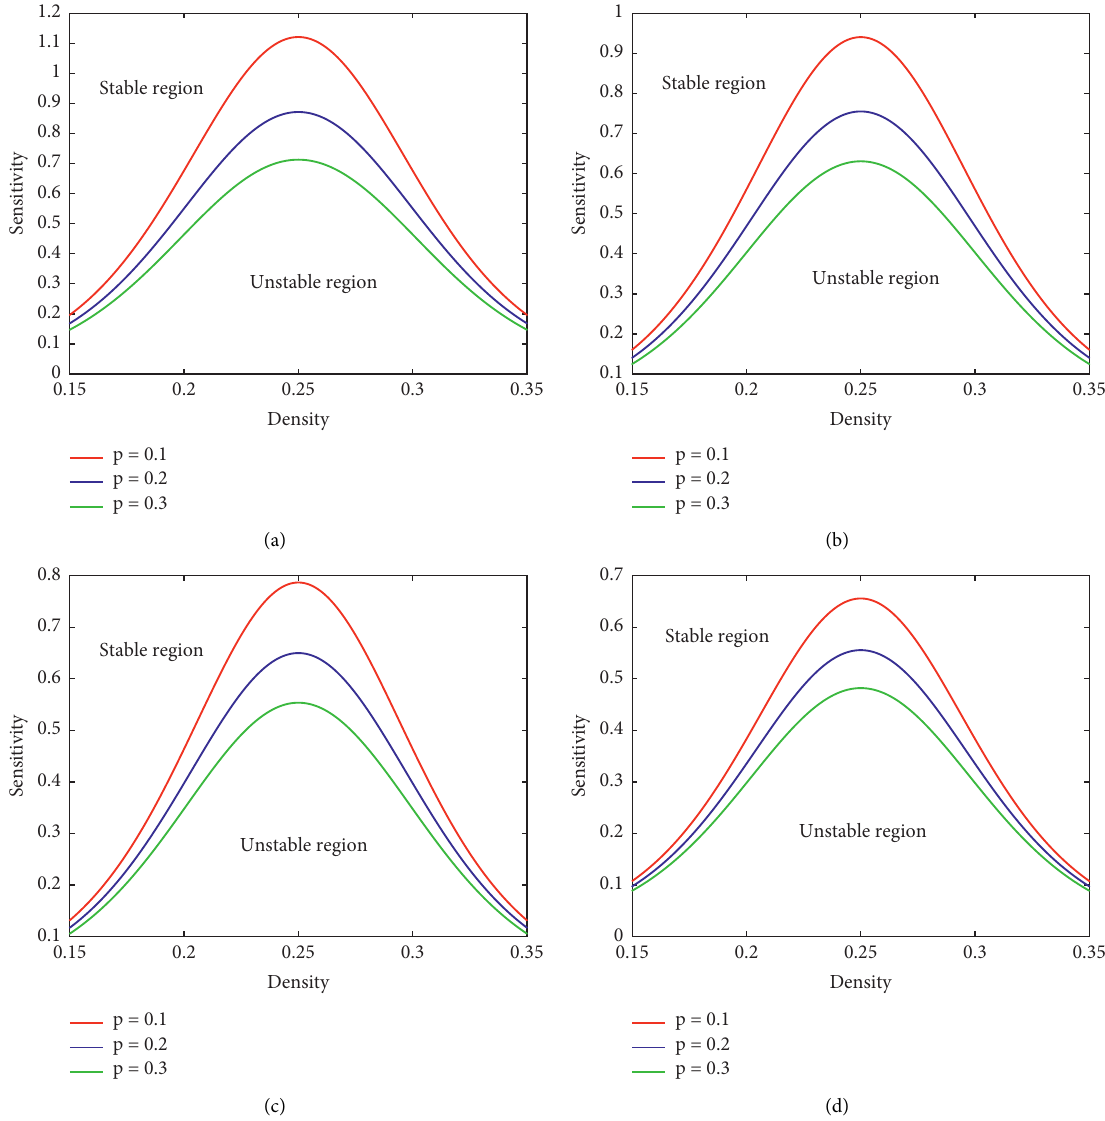
Figure 3: The neutral stability curves for τ � 1 . 5 for different values of c and p : (a) c � 0 . 05; (b) c � 0 . 1; (c) c � 0 . 15; (d) c � 0 .